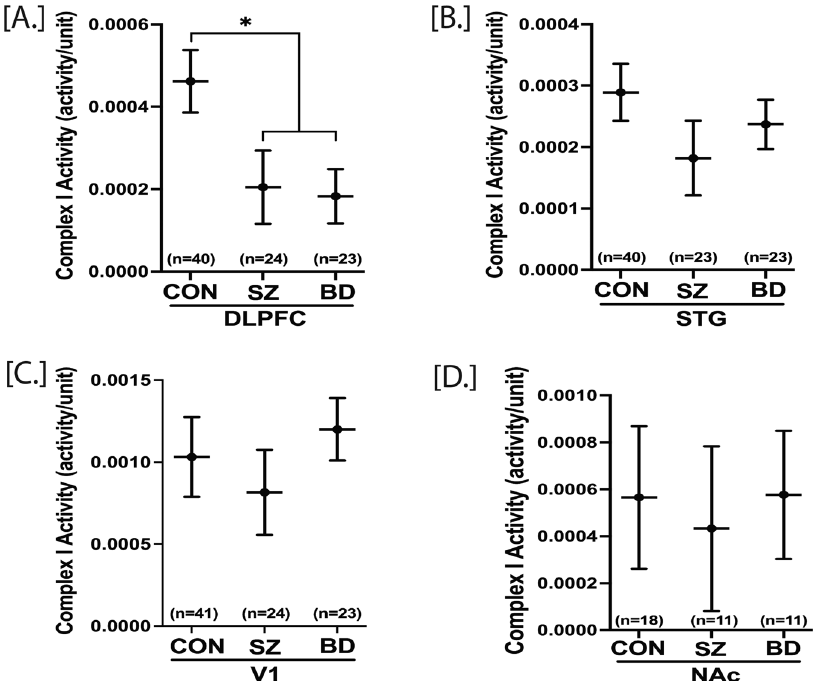
Fig. 4 Complex I activity in postmortem DLPFC, STG, V1 and NAc of control (CON), schizophrenia (SZ), and bipolar disorder (BD) groups. A repeated measure analysis was performed for statistical signi fi cance with adjustment of age and sex. DLPFC, V1 and STG complex I activity were analyzed together, whereas NAc complex I activity was analyzed individually. DLPFC complex I activity was signi fi cantly lower in both SZ and BD compared to the control group ( A ). There were no signi fi cant group differences in STG, V1, and NAc ( B – D ). All data are represented as least square mean (LSM) ± Std. error. p < 0.05 is denoted by *, otherwise p >